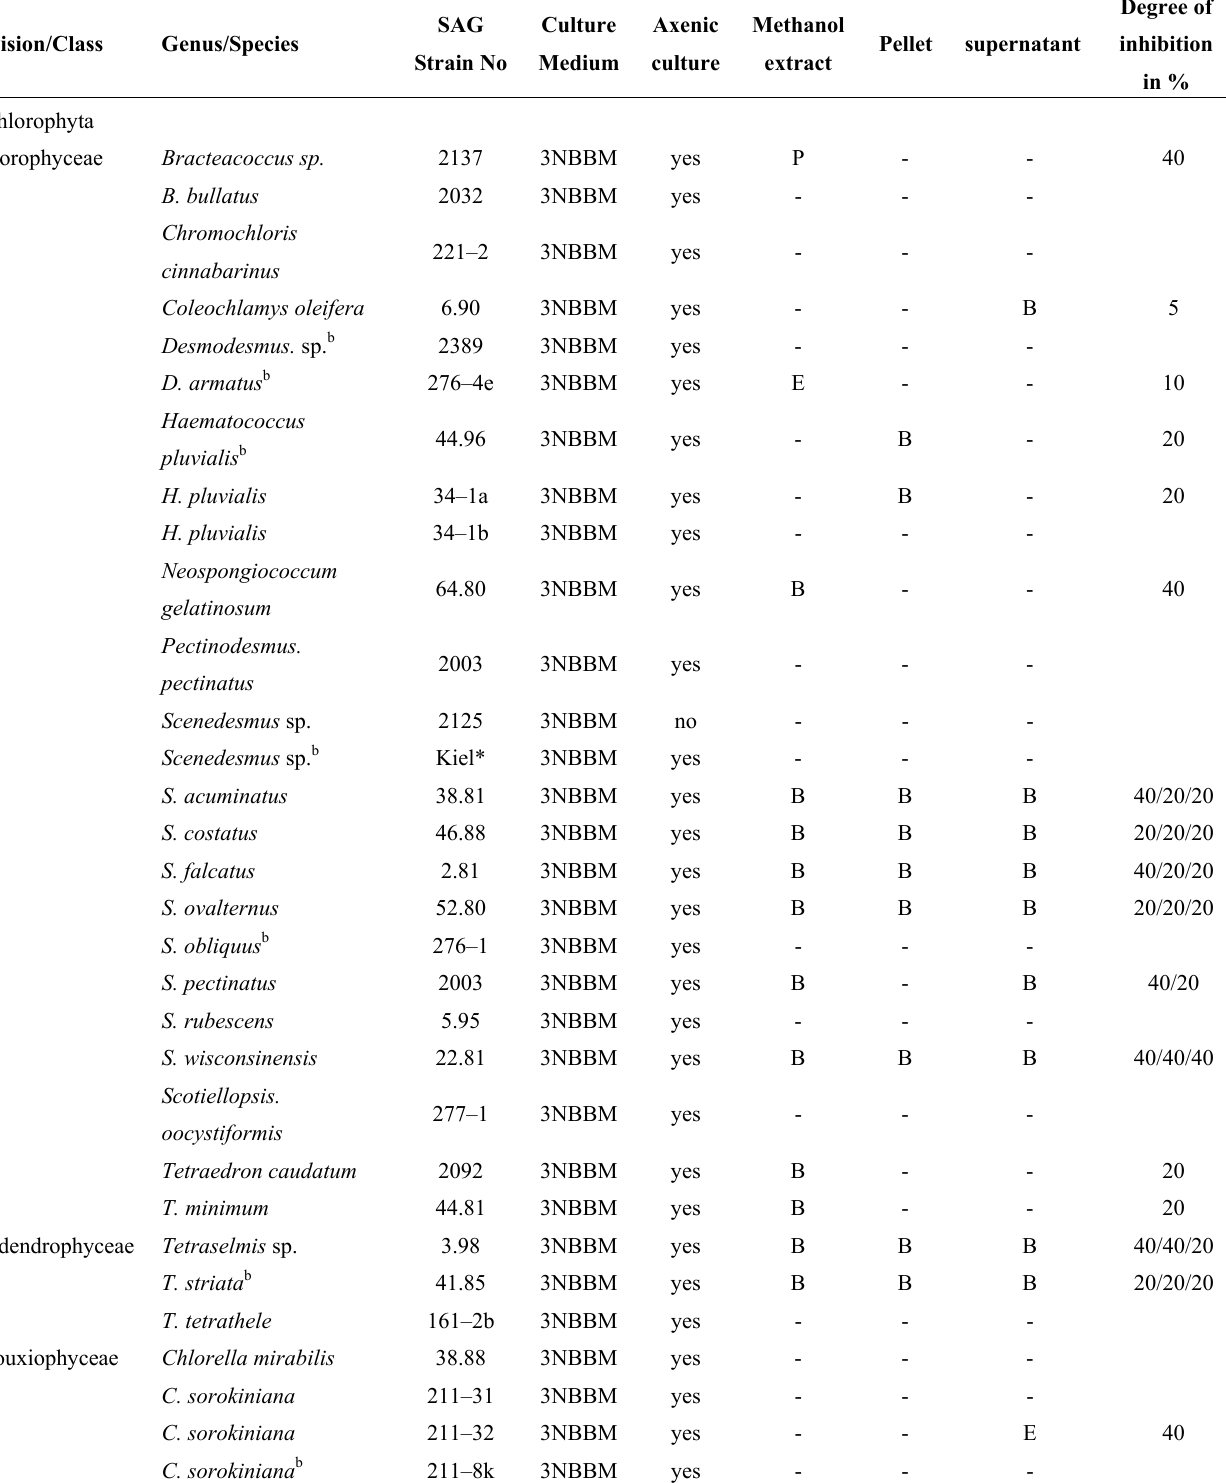
Table 2. Antibacterial and antifungal effects from microalgae and cyanobacteria against Bacillus subtilis DSM 10 (B), Escherichia coli DSM 18039 (E), Pseudomonas fluorescens DSM 50090 (P), Candida albicans DSM 1386 (C) and Saccharomyces. cerevisiae S 150– 2b ATCC 96686 (S). Activities are given in percent (%) for bacteria as well as + (< 10 mm diameter) and ++ ( ≥ 10 mm diameter) for fungi and—no